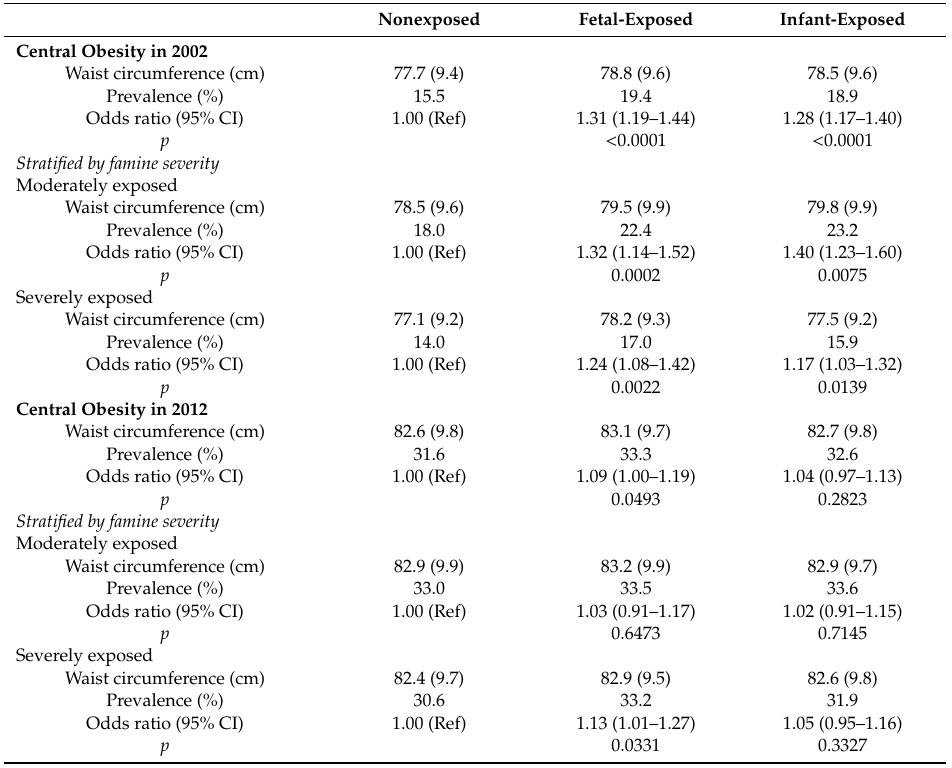
Table 2. Associations of famine exposure with central obesity risk in di ff erent severity of famine